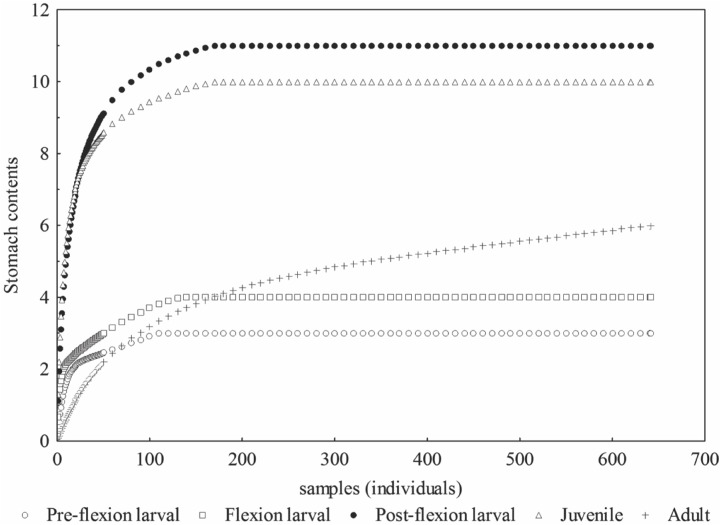
Rarefaction curves according to the number of stomachs with food at different developmental stages of P. squamosissimus in Xambrê Lake, Upper Paraná River floodplain, Paraná State, Brazil.